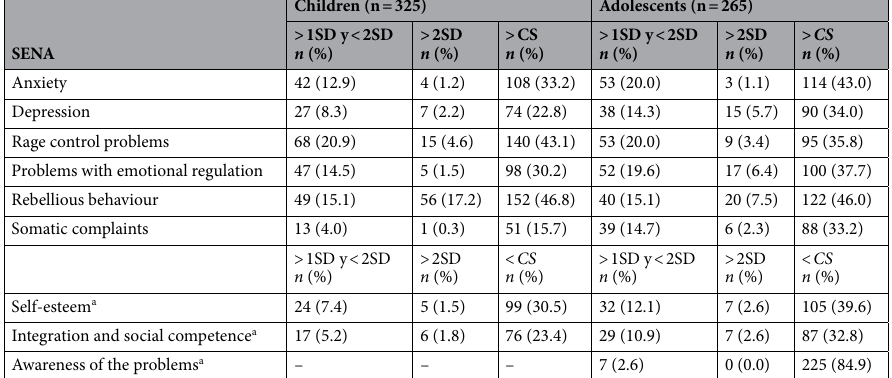
Table 1. Prevalence in mental health problems in children and teenagers in Spain during confinement. SD are the ones from the normal population of SENA technical manual. CS The clinical sample score of the technical manual. a The distance in standard deviations is below average.